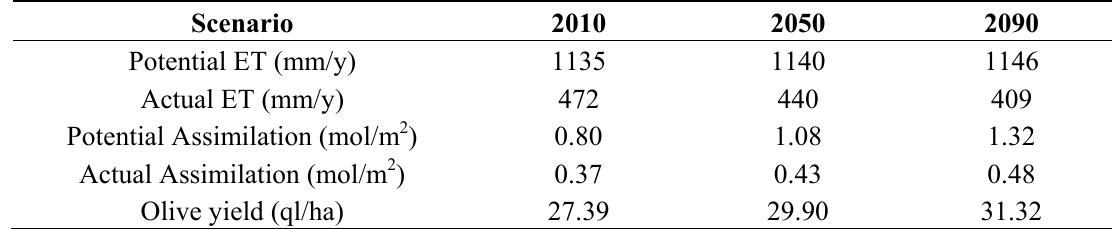
Table 2. Modeled mean values in the three considered